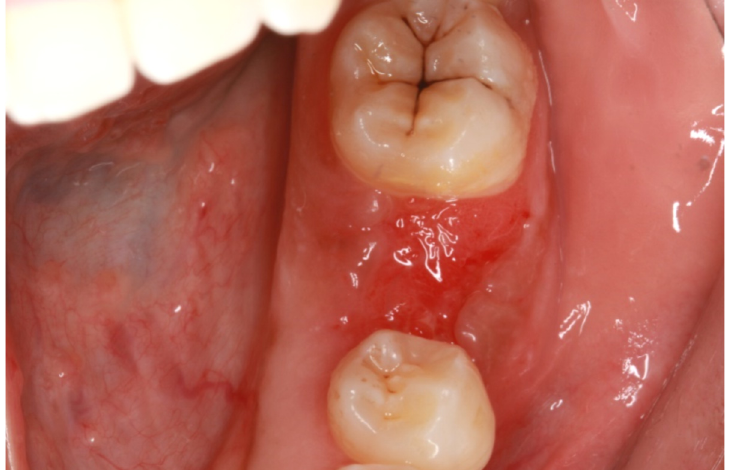
Figure 2. A schematic clinical photography series showing alveolar socket preservation performed on lower molar and utilization of dPTFE membrane secured by simple interrupted suturing technique. Note that the exposure of the barrier membrane is permissible, due to small microspores in properties, preventing bacterial ingress and, thus, simplifying surgical procedure. The final photo shows review of the surgical site upon removal of dPTFE membrane a month later.